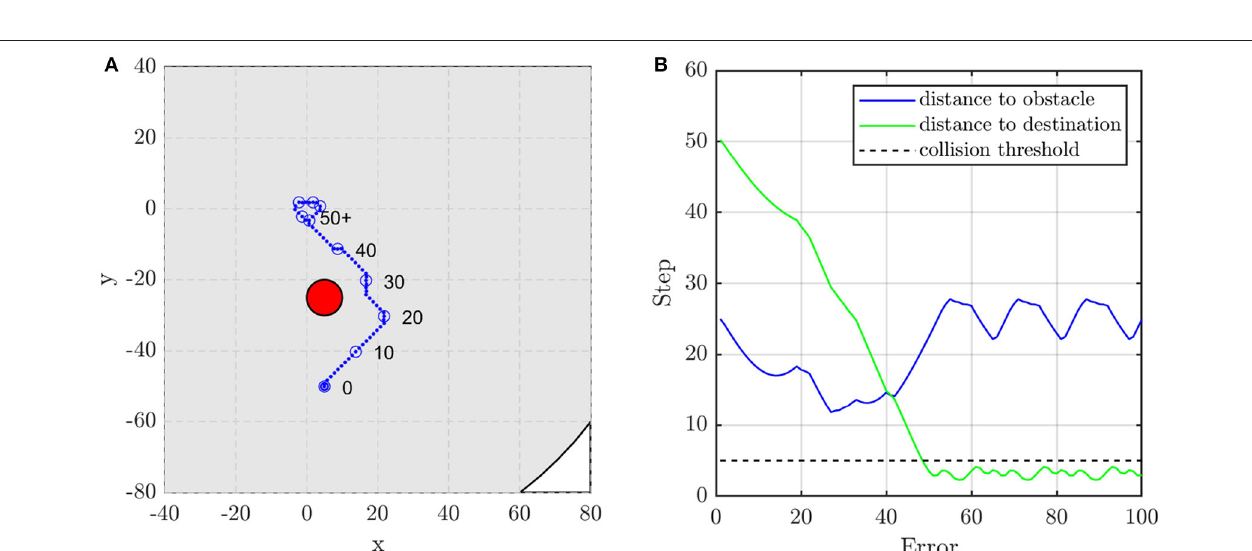
FIGURE 9 | The agent’s (A) trajectory, and (B) distance to obstacle and destination when the obstacle is not on the line between the agent’s initial and target position. The red circle is the obstacle with the radius of d safe and the blue dots are the trace of the agent.